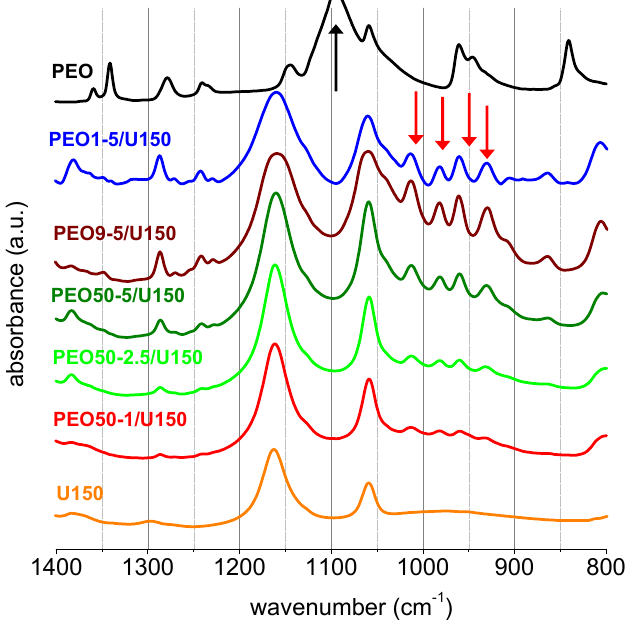
Figure 2. FT-IR of polyethylene oxide (PEO), U150 and the polymer gel electrolytes (PGEs) PEO1-5 / U150, PEO9-5/U150, PEO50-5/U150, PEO50-2.5/U150, PEO50-1/U150.